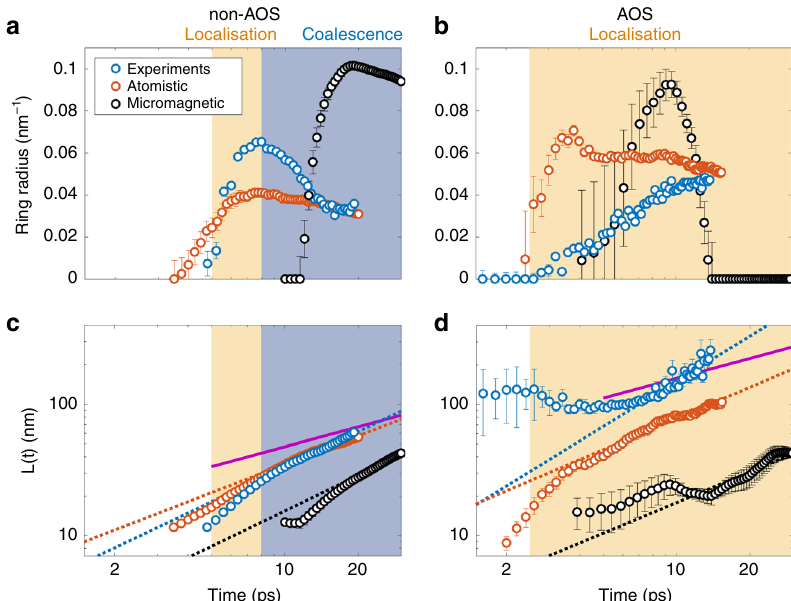
Fig. 7 Magnon localisation and coalescence. The ring radius of the Lorentzian feature is shown for a non-AOS and b AOS. Time is plotted in logarithmic scale. Symbols represent experimental (blue circles), atomistic (red circles), and micromagnetic (black circles) data. The average magnon drop diameter L ( t ) is shown in log – log scale for c non-AOS and d AOS. Dotted lines with corresponding colour code are power-law fi ts. The magenta solid line indicates the Lifshitz – Cahn – Allen power law. While L ( t ) increases according to a power law for all cases, the expanding ring radius is a signature of magnon localisation, indicated by the gold-shaded area. The shrinking ring radius observed only for the non-AOS case is the signature of magnon coalescence, indicated by the blue-shaded area. Error bars represent standard